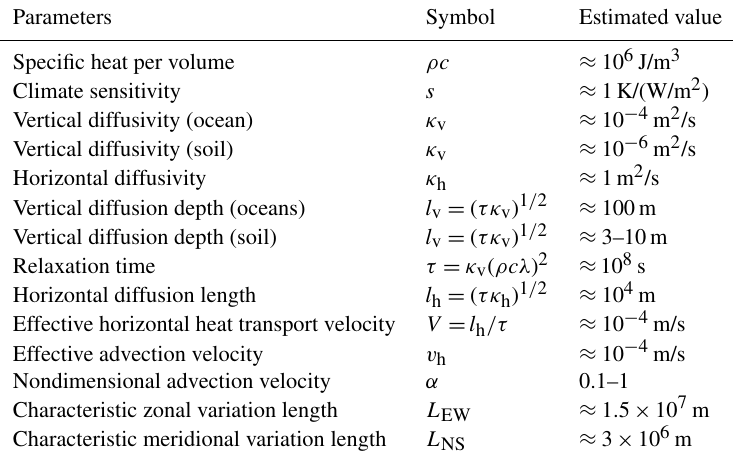
Table 1. Empirical estimates of the parameters used in this paper; see Appendix A for details. Parameters Symbol